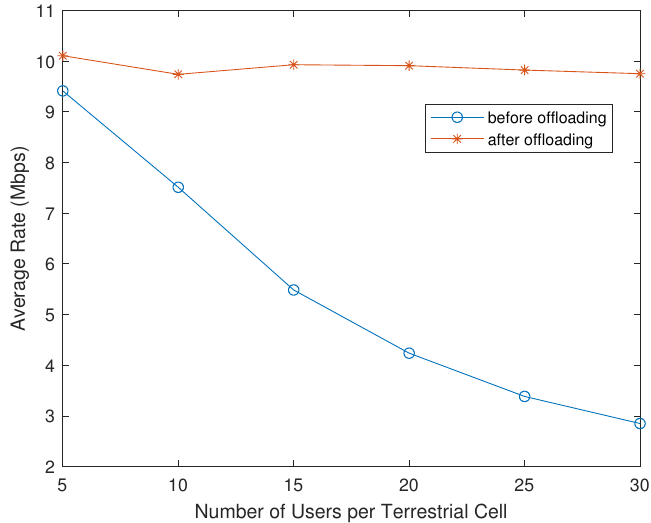
Figure 9. Average rate with different